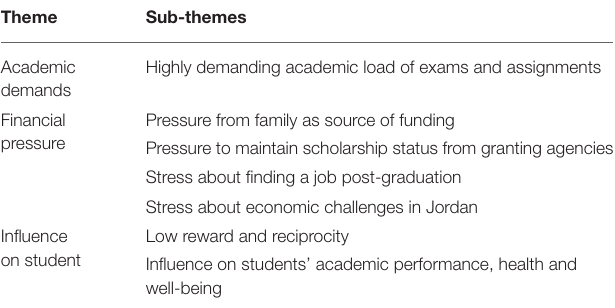
TABLE 7 | Themes and sub-themes from qualitative